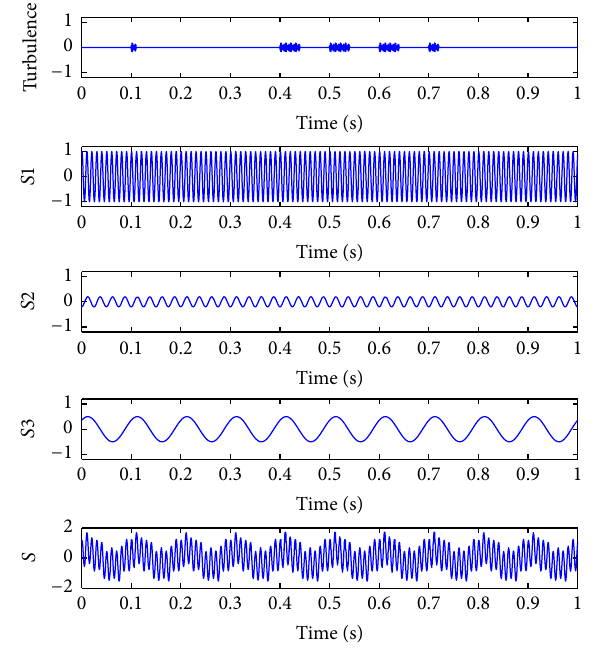
Figure 1: Original